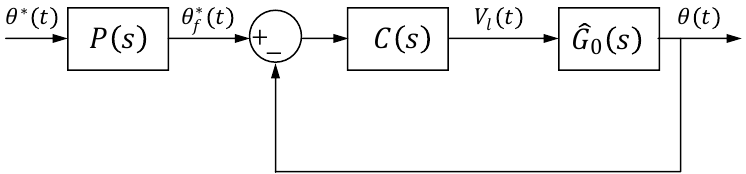
Figure 6. Linear control